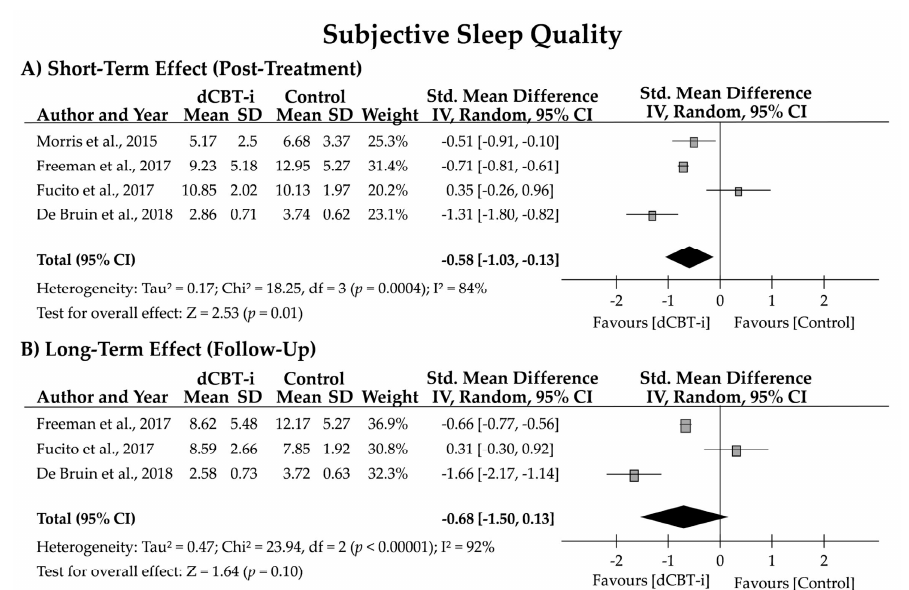
Figure 2. Forest plot for the short- and long-term effects of dCBT-i on subjective sleep quality (SQ). Subjective SQ was evaluated using the Pittsburgh Sleep Quality Index (PSQI; Morris et al., 2015 [30]; Fucito et al., 2017 [44]), Insomnia Severity Index (ISI; Freeman et al., 2017 [43]), or Holland Sleep Disorder Questionnaire-Insomnia (HSDQi; De Bruin et al., 2018 [45]). SD, standard deviation; CI, confidence interval.